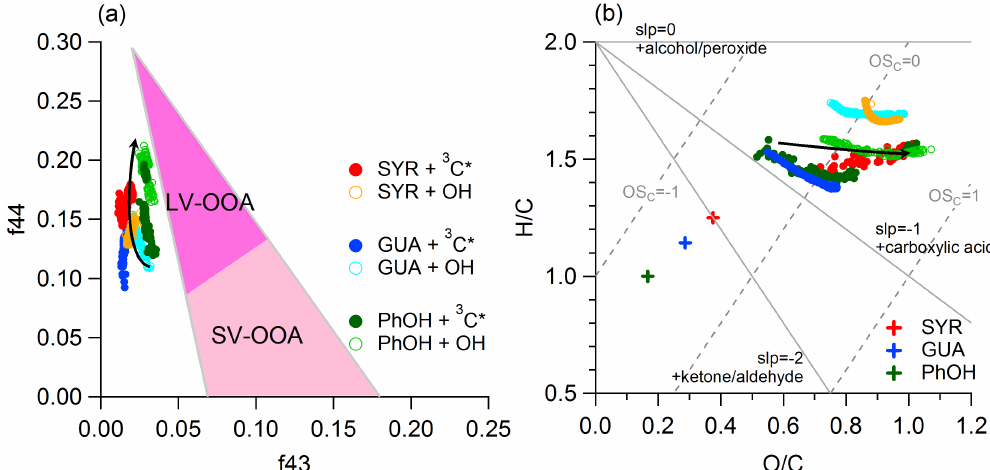
Figure 6. Evolution profiles of phenolic aqSOA in (a) the f 44 vs. f 43 space and (b) the H / C vs. O / C space based on AMS measurements. The shaded triangle in (a) defines the region where typical ambient SOA lie (Ng et al., 2010). Different experimental conditions are repre- sented by the symbols shown in the legend. Phenolic precursors are represented by the “ + ” symbols in (b) . Lines with slopes of 0, − 1, and − 2 indicate the addition of alcohol/peroxide, carboxylic acid, and ketone/aldehyde functional group, respectively. Dashed lines indicate OS of − 1, 0, and 1,